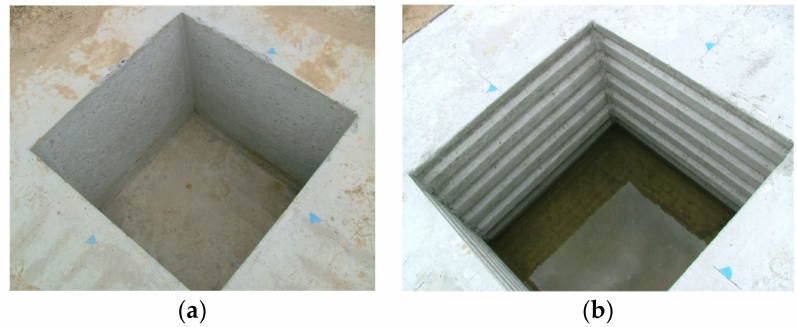
Figure 7. Internal surfaces of PF: ( a ) with smooth surface, ( b ) with keyed